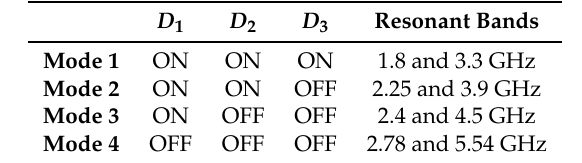
Table 1. States of the PIN diodes for various operating modes.